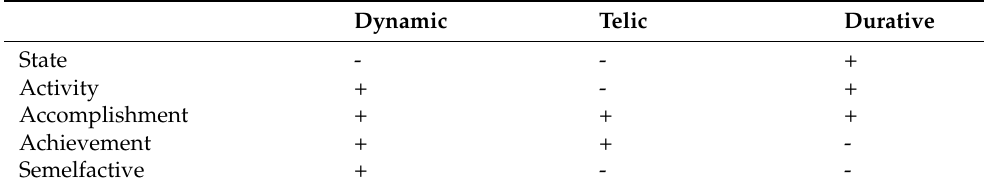
Table 1. Properties distinguishing Aktionsart classes (Smith 1997, p.